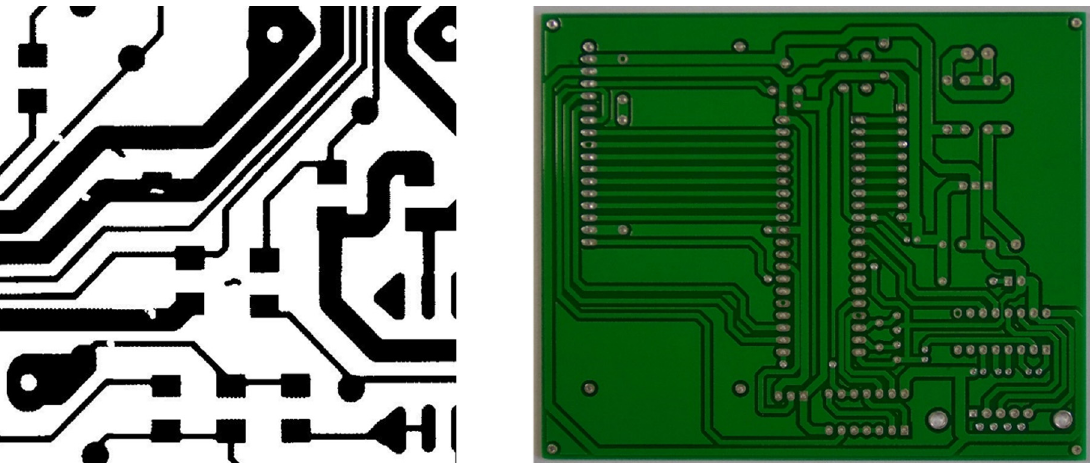
Figure 1. Two images from different datasets. Left is from DeepPCB and right is from PKU-PCB.